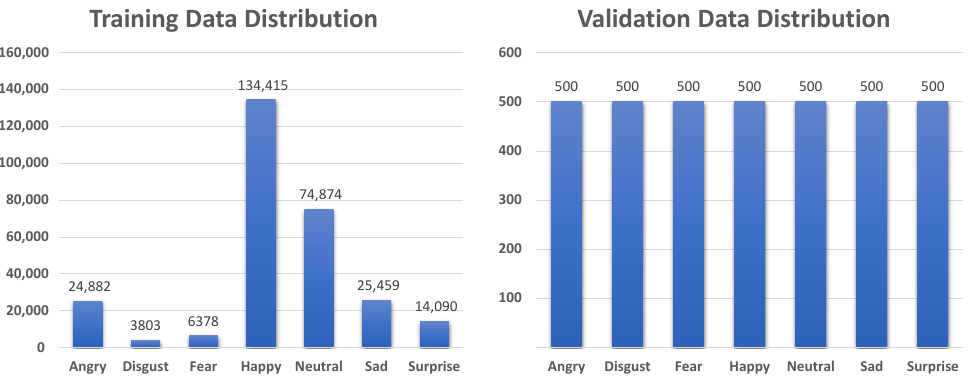
Figure 7. Data distribution for training and validation on AffectNet dataset [16].